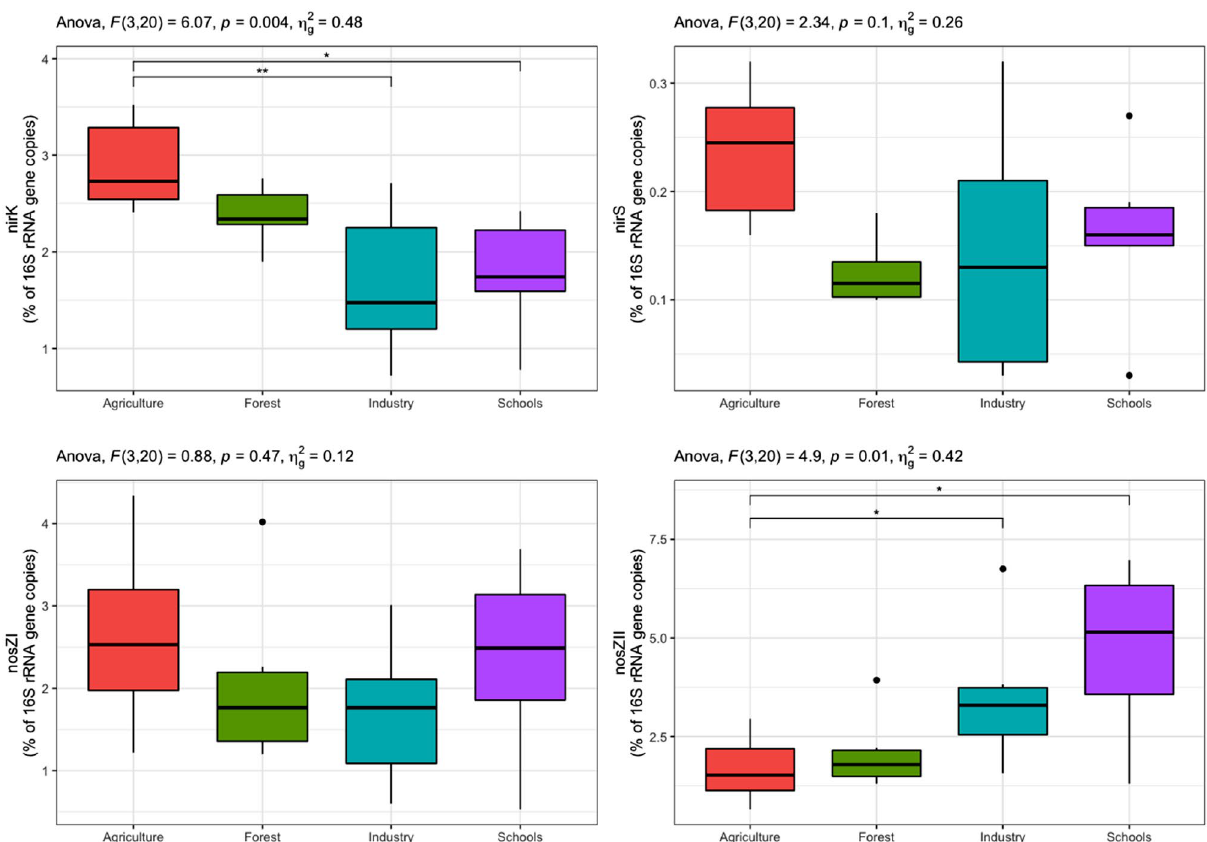
Figure 3. The %age abundance of nir K, nirS , nosZ I and nosZ II genes normalised to 16S rRNA gene abundance in soil samples derived from agricultural, industrial, forested and schoolyard areas. Spreads in the